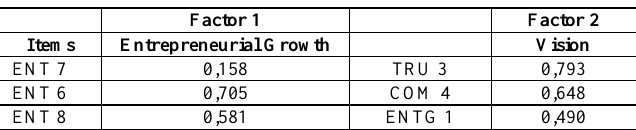
Table 2: Intervening variables: Entrepreneurial